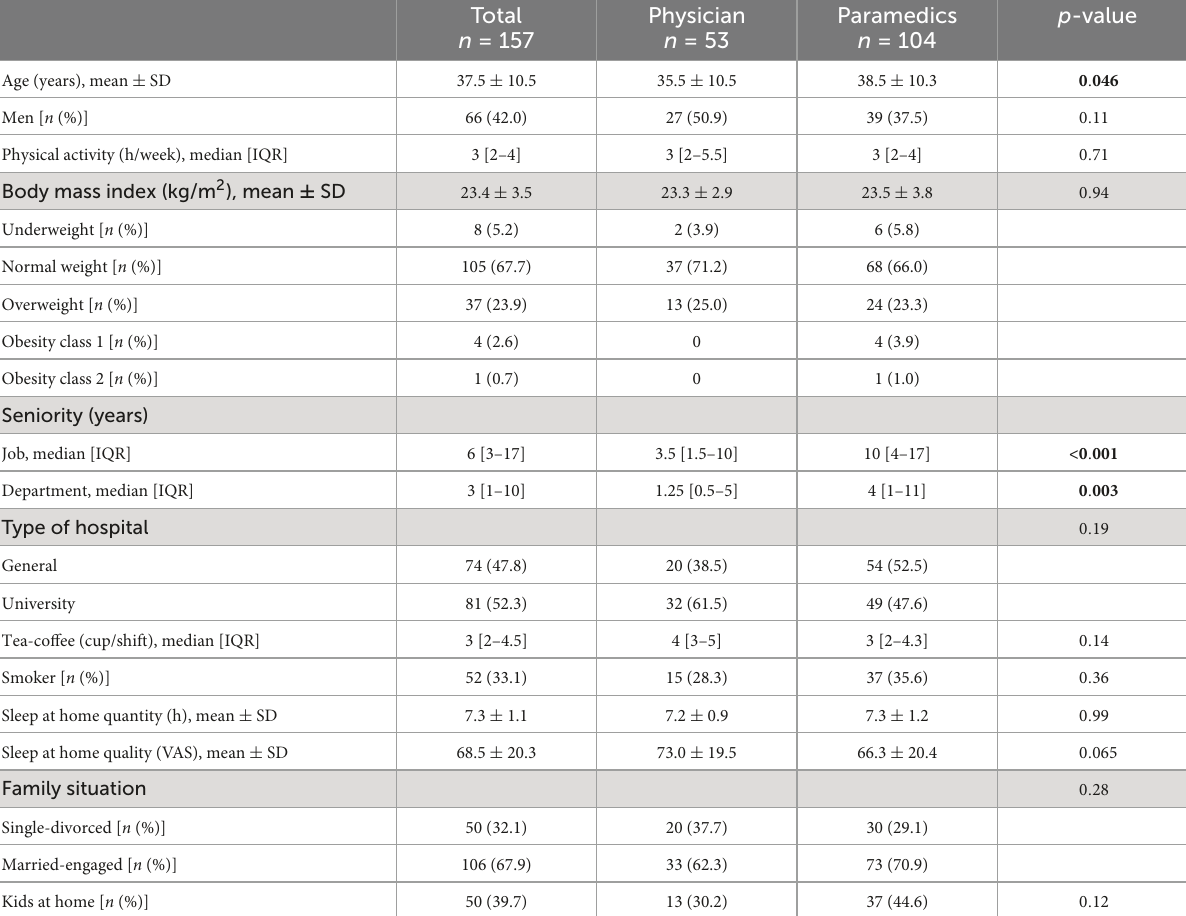
TABLE 1 Characteristics of the